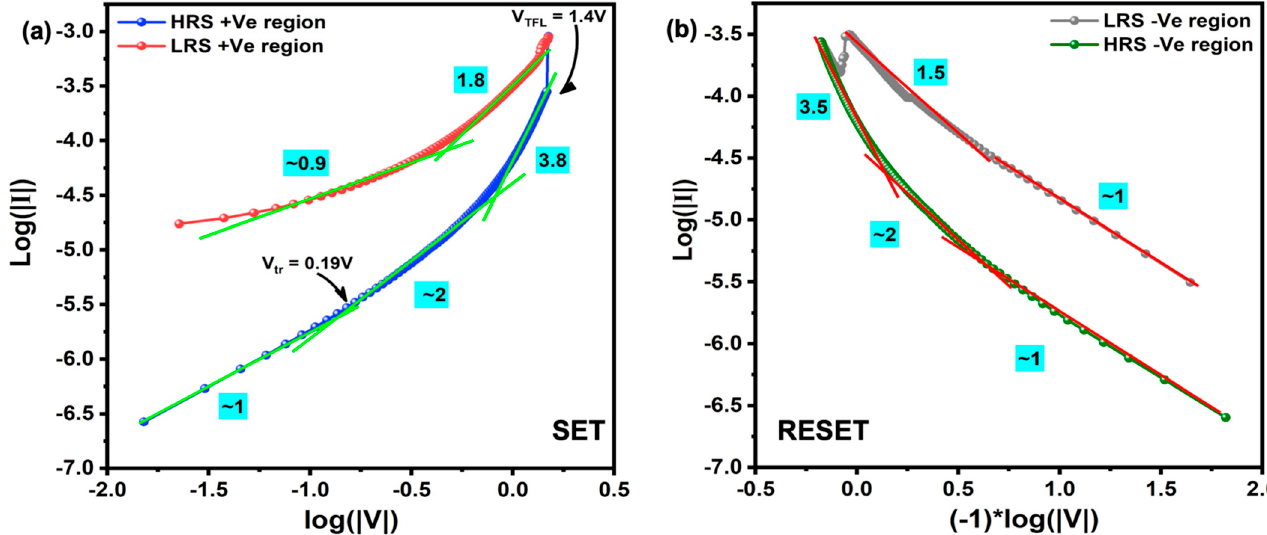
Figure 7 . Double logarithmic plot of ( a ) SET and ( b ) RESET regions along with the slope for single-nanowire device.